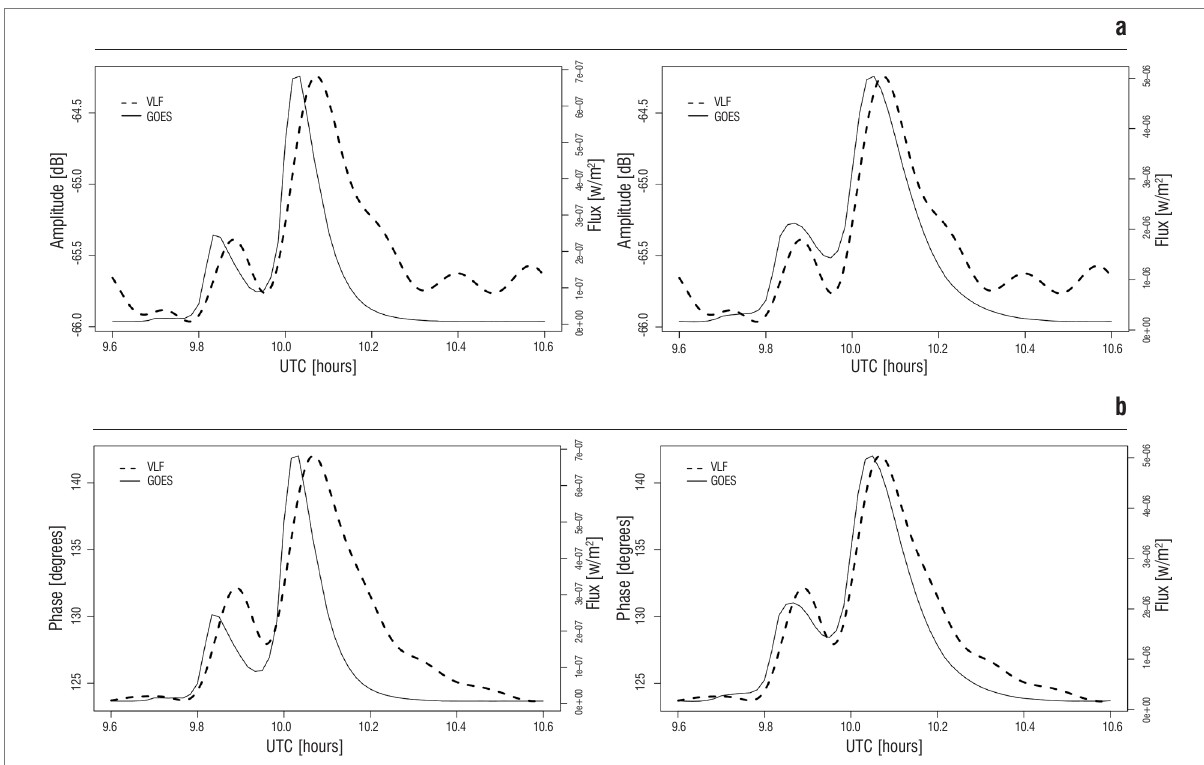
Figure 6: Calculated variation of the signal from (a) GBZ (amplitude) and (b) GQD (phase) as a function of distance along the transmission path during the occurrence of the solar flare on 13 December 2007.